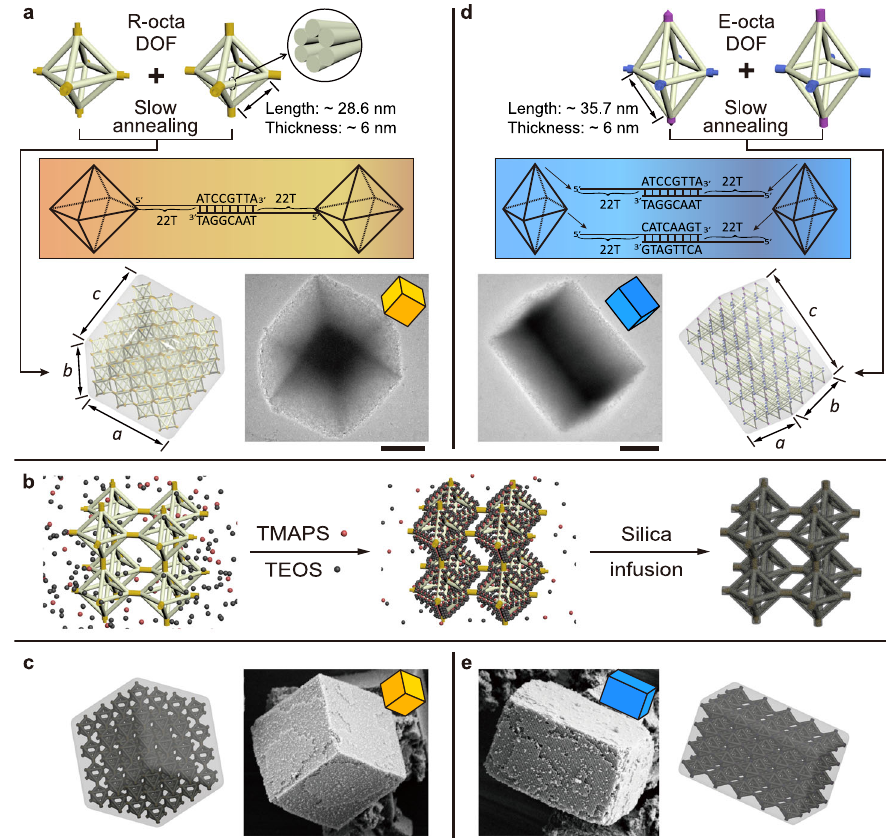
Fig. 1 Formation of microcrystals with Wulff shapes. a Crystallization of cubic microcrystals ( a = b = c ) from R-octa DOFs through a slow annealing process. Middle scheme: DNA sequences of sticky ends in the R-octa system. Bottom right panel: representative TEM image of a bare microcrystal. b Schematic illustration of the silica-encapsulation strategy for DNA microcrystals. The process is realized through the involvement of TMAPS (red spheres) and TEOS (black spheres), see details in Methods section. c Model (left) and representative SEM image (right) of an encapsulated microcrystal with the same orientation. d Crystallization of cuboid microcrystals ( a = b < c ) from E-o c ta DOFs through a slow annealing procedure. Middle scheme: DNA sequences of sticky ends in the E-octa system. Bottom left panel: representative TEM image of a bare microcrystal. e Representative SEM image (left) and model (right) of an encapsulated microcrystal with a cuboid shape. Scale bars: 2 μ m. Note that: the number of monomers drawn in the conceptual drawing in ( a and d ) are much less than real condition to highlight the linking mode between